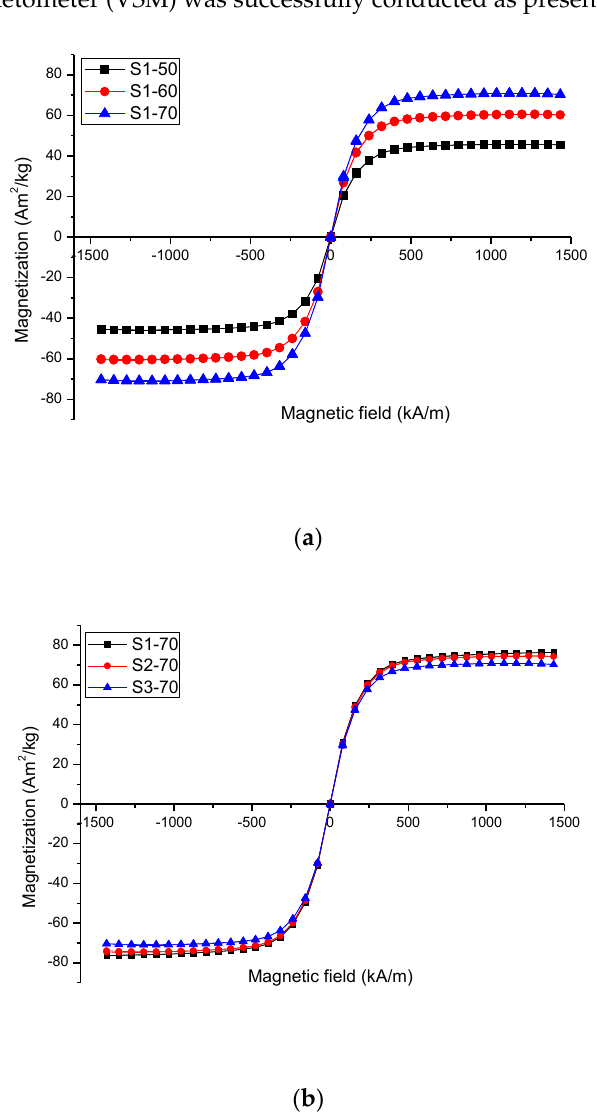
Figure 2. VSM profile of polyvinyl alcohol (PVA) hydrogel MRPs with ( a ) di ff erent carbonyl iron particles (CIPs) contents and ( b ) di ff erent types of